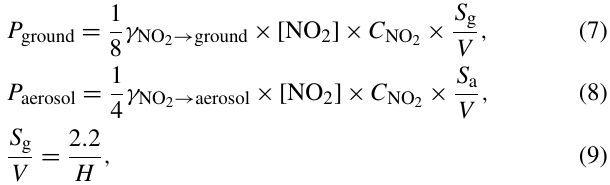
Figure 3. The mean nocturnal variations of (a) P net and (c) HONO. In each box, the blue line and red circle refer to the median and mean, respectively. The upper and lower boundaries in each box represent the 75th and the 25th percentiles; the whiskers above and below each box represent the 95th and 5th